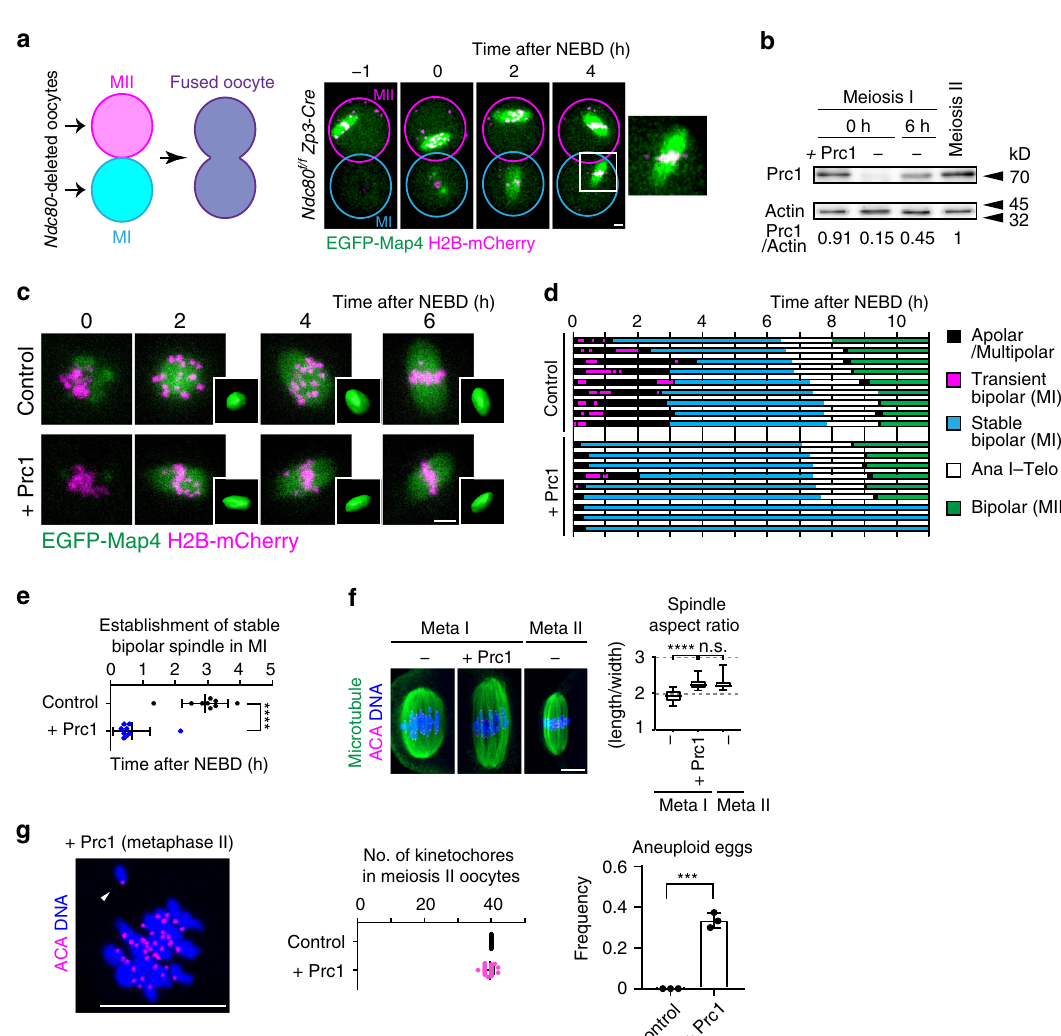
Fig. 6 Cytoplasm containing upregulated Prc1 facilitates kinetochore-independent pathways for spindle bipolarization in MII. a MII cytoplasm supports Ndc80-independent spindle bipolarization. An Ndc80 f/f Zp3-Cre oocyte in metaphase II (MII) and an Ndc80 f/f Zp3-Cre oocyte at the GV stage (MI) were fused. EGFP-Map4 (microtubules, green) and H2B-mCherry (chromosomes, magenta) are shown. Bipolar spindle formation around MI chromosomes (magni fi ed) was observed in 10 of 10 oocytes from three independent experiments. Time after NEBD of the MI nucleus (h). See also Supplementary Movie 8. b Upregulation of Prc1 in MII and arti fi cial increase in Prc1 levels in MI. Western blotting of oocytes at MI (0 and 6 h after NEBD), and at MII (16 h). The Prc1 level at 0 h was arti fi cially increased ( + Prc1). Fifty oocytes were used in each sample. A full scan image is provided in the Source Data fi le. c Live imaging of oocytes expressing increased Prc1. EGFP-Map4 (microtubules, green) and H2B-mCherry (chromosomes, magenta) were monitored. Spindles were reconstructed in 3D. Time after NEBD. Three independent experiments were performed. See also Supplementary Movie 9. d Increased Prc1 accelerates spindle bipolarization. Spindles reconstructed in 3D were categorized (see Methods). e Acceleration of bipolar spindle establishment. Time at which a stable bipolar spindle was established are plotted ( n = 9, 9 oocytes). The mean + / − SD are shown. **** p = 1.3E − 06. f MII-like spindle shapes. Oocytes were immunostained for microtubules (green), kinetochores (ACA, magenta) and DNA (Hoechst33342, blue) at metaphase I (6 h after NEBD) and metaphase II (16 h after NEBD). Aspect ratios (length/width) were plotted ( n = 19, 8, 11 oocytes). Boxes show the 25th to 75th percentiles and whiskers show the 1st to 99th percentiles. **** p = 2.54E − 05. n.s., not signi fi cant. g Increased Prc1 increases aneuploidy in eggs. Oocytes at metaphase II were immunostained for kinetochores (ACA, magenta) and counterstained for DNA (Hoechst33342, blue). Arrowheads indicate a misaligned chromatid in an aneuploid egg. The number of kinetochores were counted ( n = 33, 40 oocytes from three independent experiments). Mean + / − SD are presented. *** p = 0.0001. Statistical values were obtained from two-tailed unpaired Student ’ s test. Scale bars, 10 μ